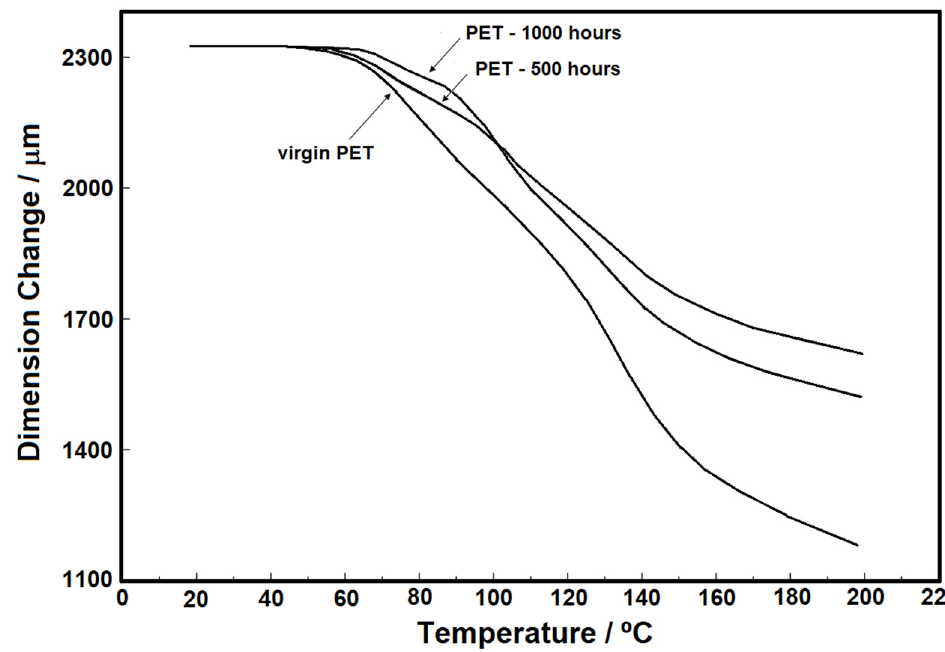
Figure 14. TMA curves of virgin PET, PET 500 h, and PET 1000 h overlapped.